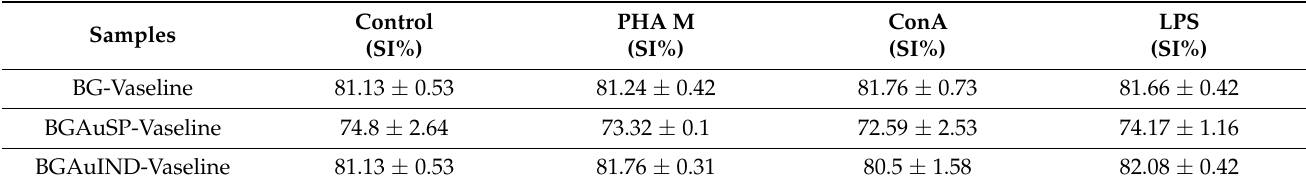
Table 1. In vivo-post-therapeutic blastic transformation